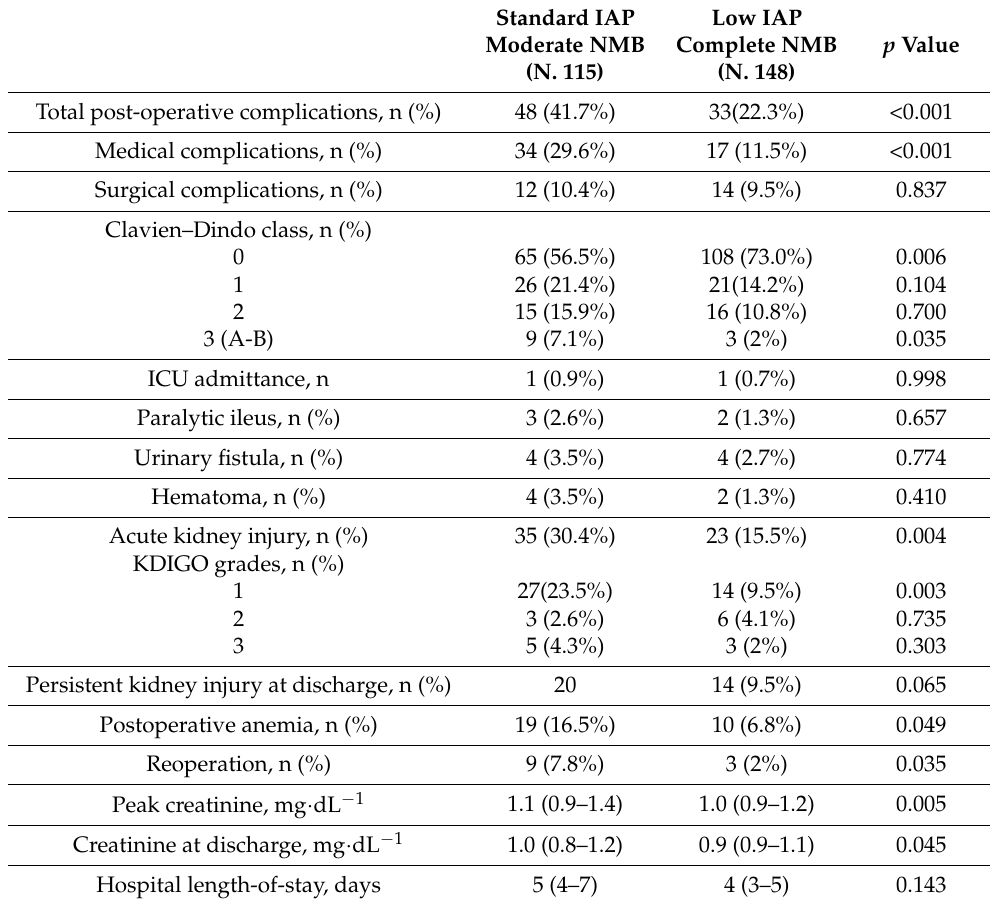
Table 4. Outcomes and post-operative